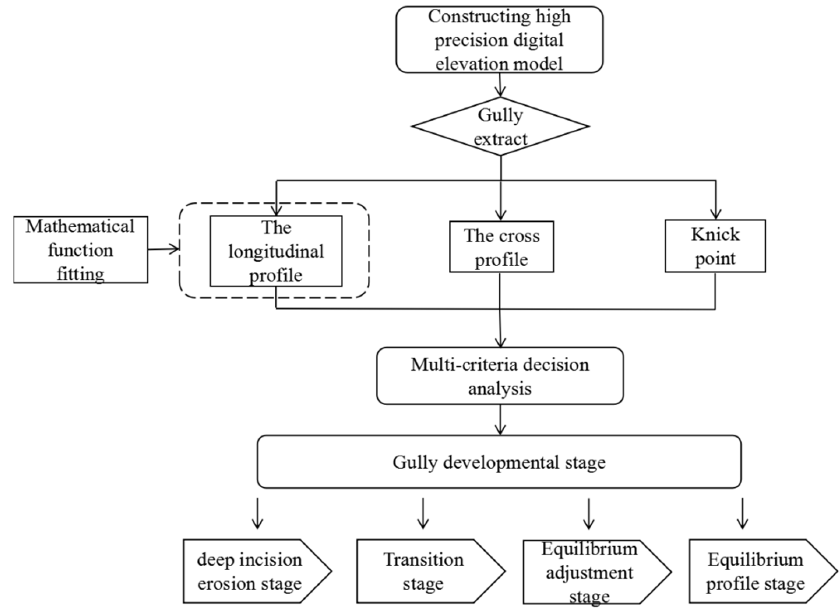
Figure 3. Methodological framework.